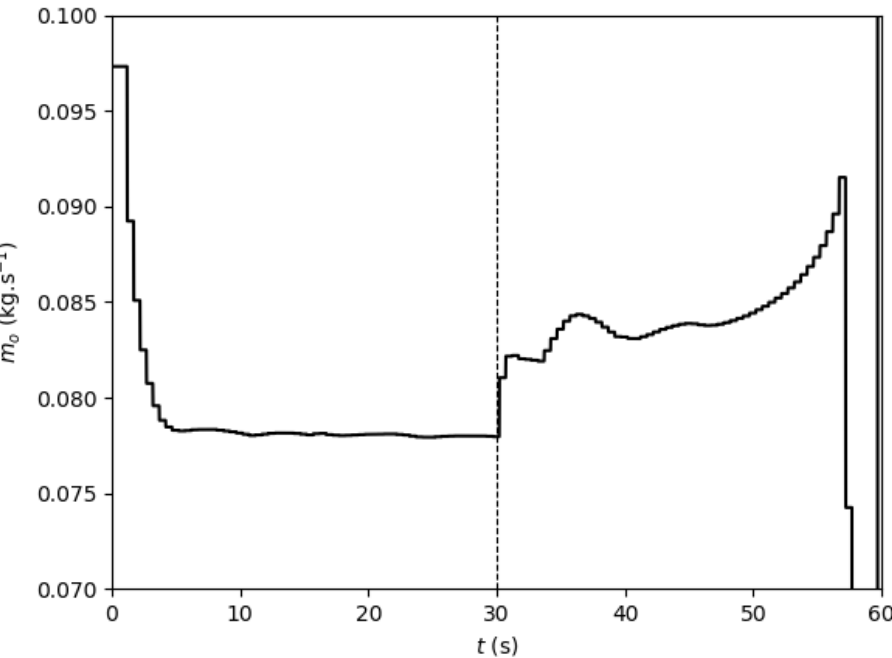
Figure 24. Oxidizer mass flow rate profile, feedback with complete regulation law, case 2.